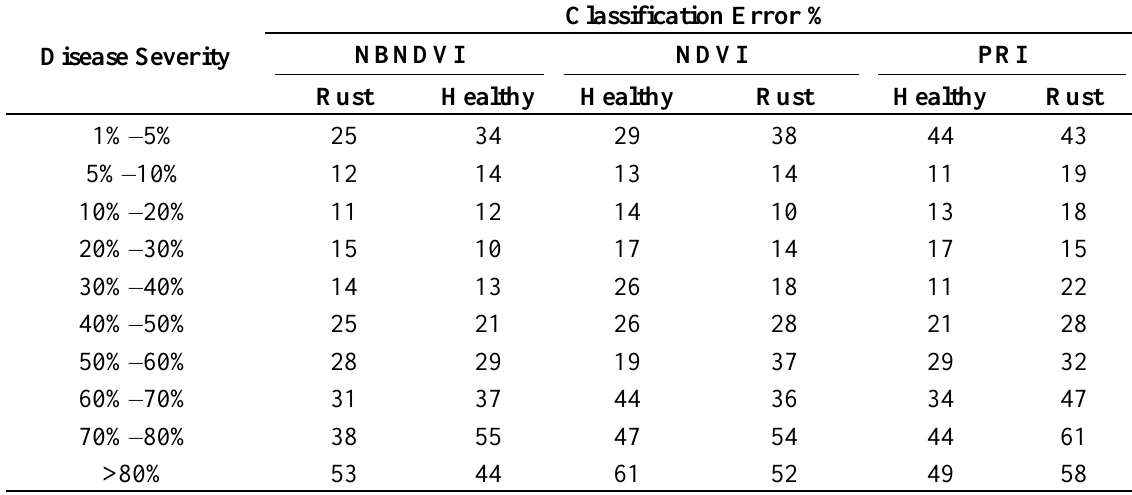
Table 4. Classification accuracy for the healthy and infected classes for NDVI, PRI and